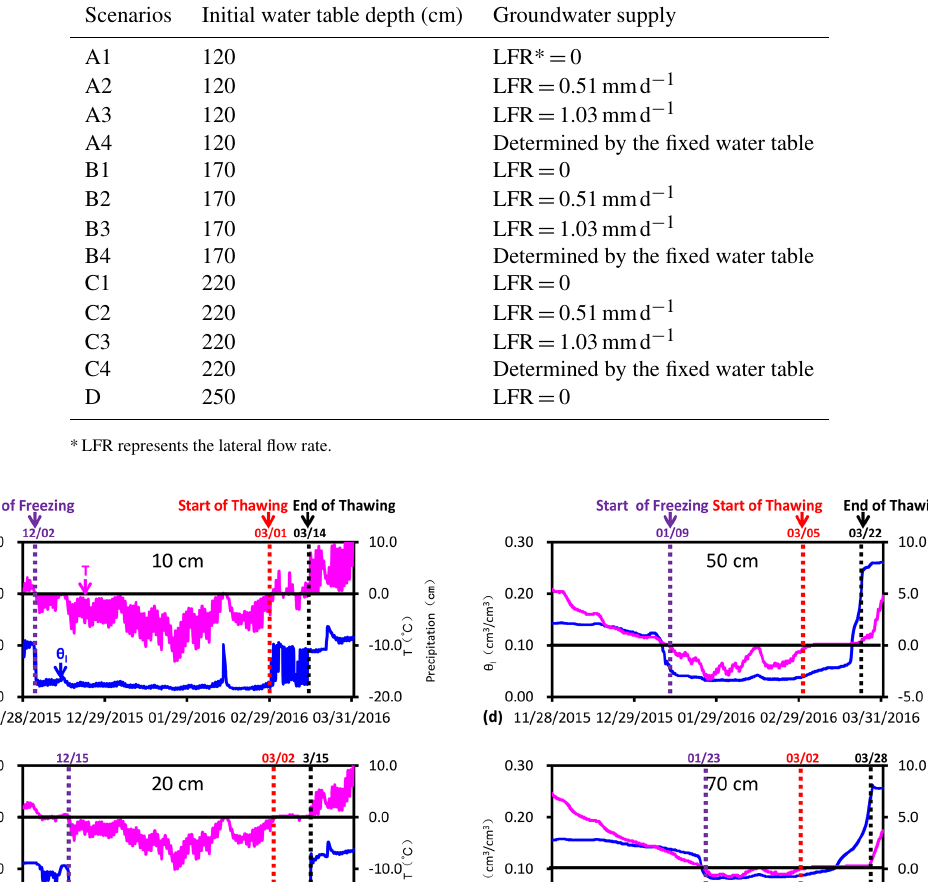
Table 2. The different scenarios of sensitivity analysis with different initial water table depths and different conditions of groundwater supply.